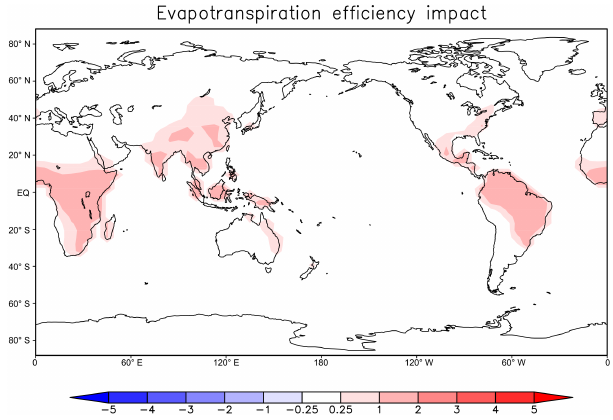
Figure 9. Evapotranspiration efficiency impact on temperature change